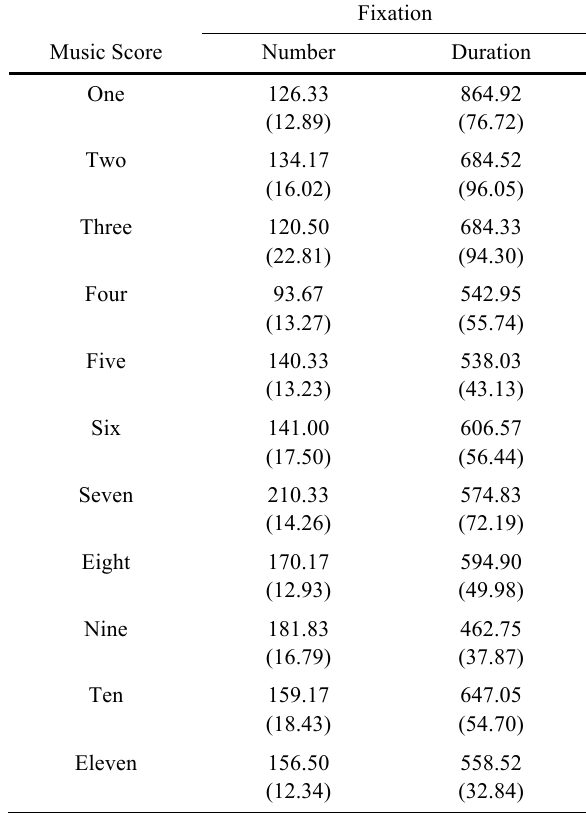
Figure 2. Fixation duration as a function of music score.